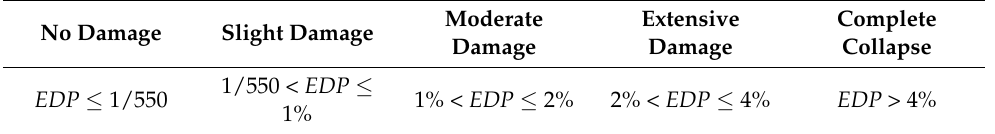
Table 1. The thresholds of the different damage